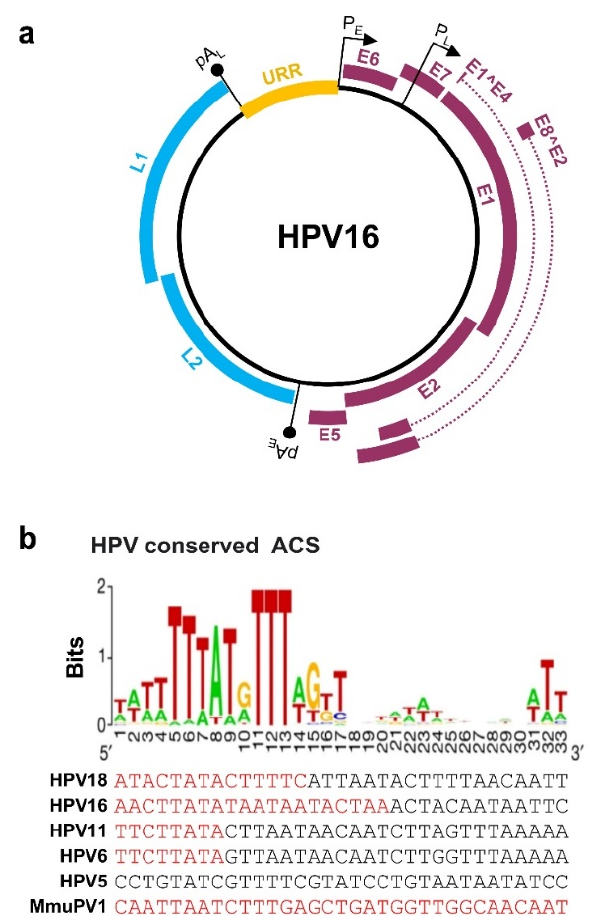
Figure 1. Papillomavirus genome structure, annotated ORFs, and conserved ACS in the origin of replication (Ori). ( a ) HPV16 genome and annotated ORFs. The non-structural proteins from the early region of the genome, including E1, E2, E1^E4, E5, E6, E7, and E8^E2, are shown in purple. The viral capsid proteins, L1 and L2, from the late region of the genome are shown in blue. URR (yellow), upstream regulatory region. P E and P L mark the early and late promoters, and pA E and pA L stand for the early and late polyadenylation sites. ( b ) Conservation of the mammalian ARS consensus sequence (ACS) [16] in the Ori of selected papillomavirus genomes. Shown in this panel